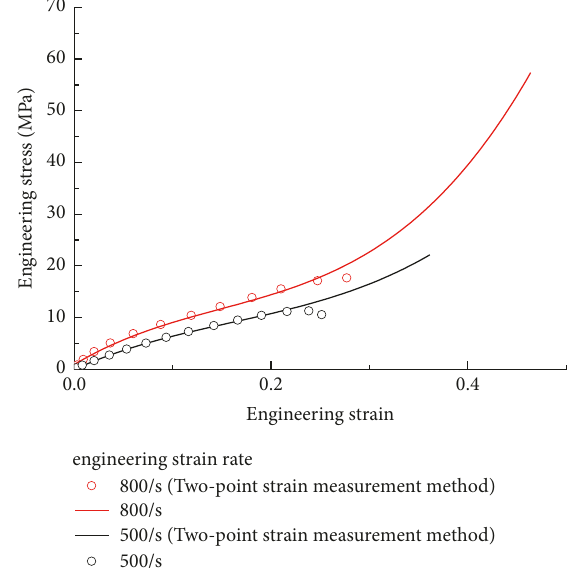
Figure 6: Comparison of engineering stress-strain curves obtained from conventional methods and wave separation